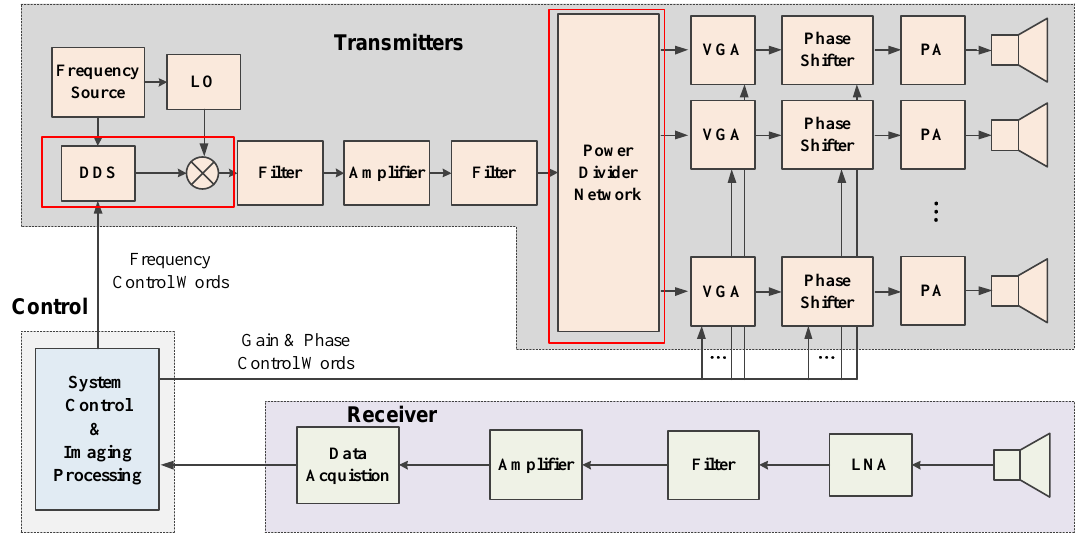
Figure 11. System architecture of